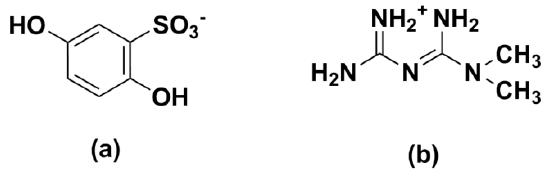
Figure 1. The chemical structures of DBS ( a ); and MET ( b ) with basic and acidic sites highlighted,